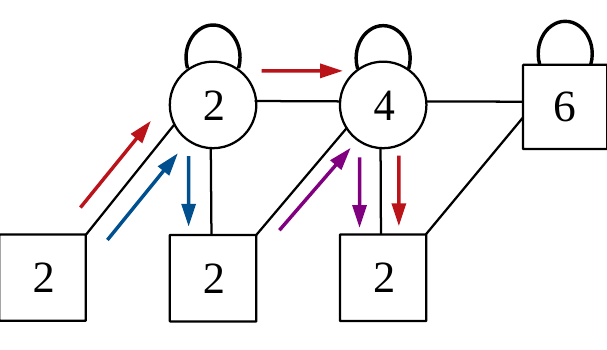
matrix in the Q = 3 y